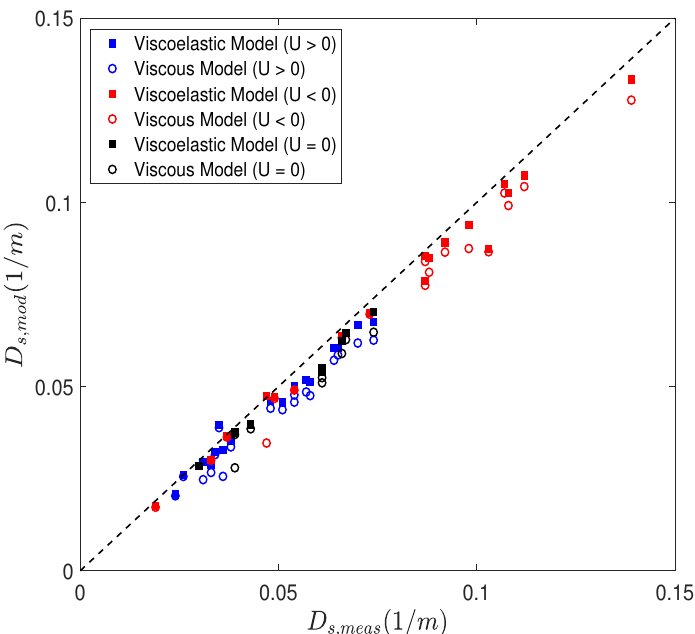
Figure 4. Comparison between the attenuation rates from the present model and laboratory experi- ments of Zhao et al. [19], U > 0 indicates experiments where current are in the same direction, and U < 0 indicates the opposite.